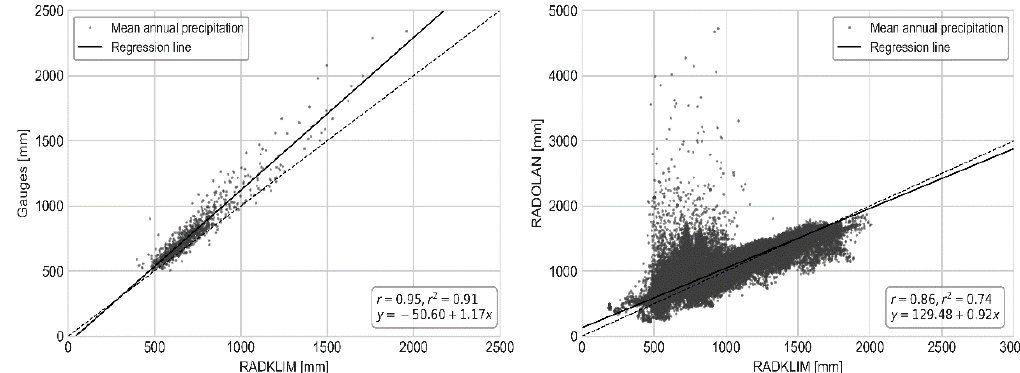
Figure 5. Comparison of mean annual precipitation sums from the 997 rain gauges and the corresponding RADKLIM pixels ( left plot ) as well as from the 392529 RADOLAN-RADKLIM pixel pairs ( right plot ).